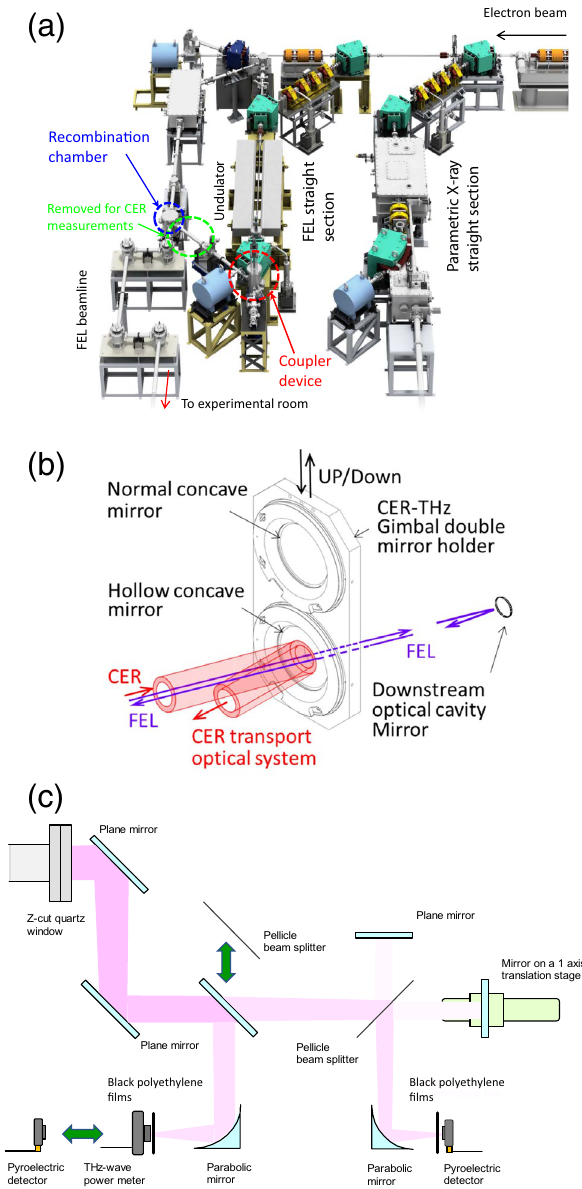
Figure 1. Experimental setup and observation system for CER beam at LEBRA. ( a ) schematic layout of two light-source straight sections and FEL beamline. ( b ) switchable normal concave and hollow concave mirrors installed in the coupler device. ( c ) schematic layout of observation system for CER beam installed between the coupler device and recombination chamber. A plane mirror and a THz-wave power meter were used to the measure of the CER power, whereas a pellicle beam splitter and a pyroelectric detector were used to measure the CER spectra. ( a ) is permitted for publication under a CC BY open access license by the copyright holder Mr. Mamoru